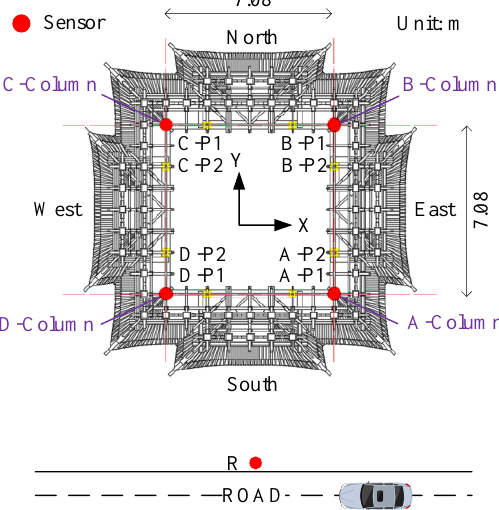
Figure 12. The layout plan of the measurement points.